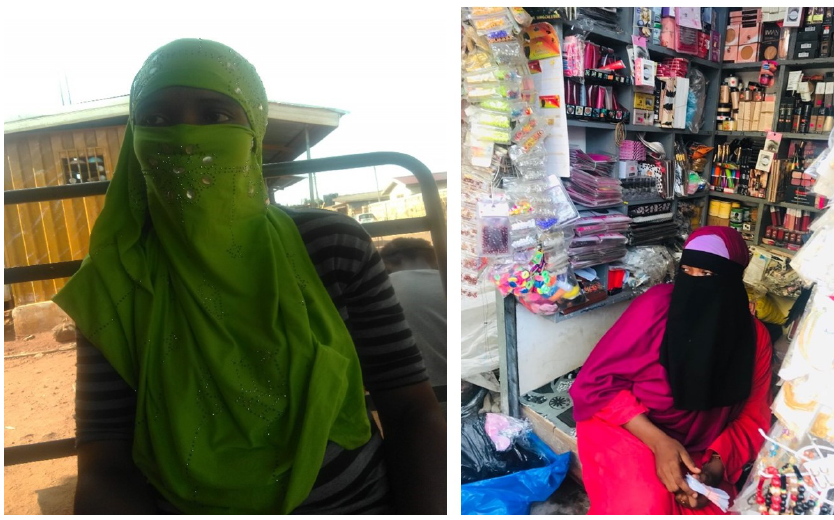
Figure 2 A hijab -like face mask (left) and niqab (right), pictures taken by the